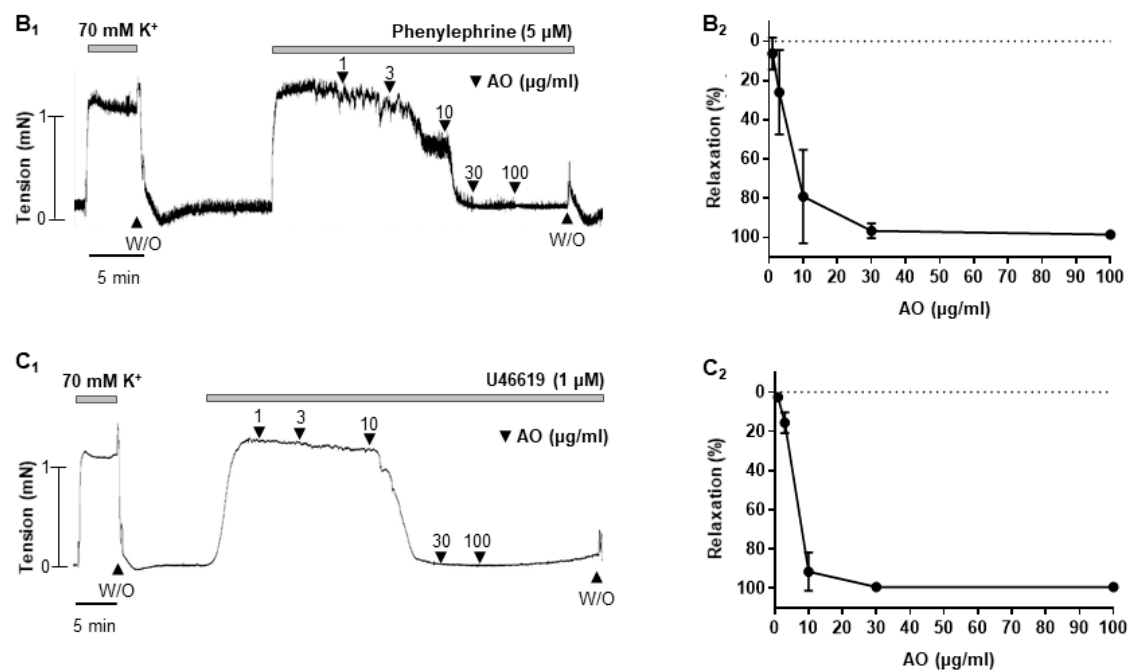
Figure 1. A. officinarum extract-induced vasodilation in rat mesenteric arteries. ( A 1 – C 1 ), data showing responses to cumulative administration of A. officinarum extract (1–100 µ g/mL) on high-K + ( A 1 ) or U46619 ( B 1 ) or phenylephrine ( C 1 ) -induced contraction. ( A 2 – C 2 ), statistical analysis of the relaxation response to A. officinarum extract. Mean ± SD (n = 7). Inset, representative trace showing responses to vehicle, DMSO (0.0005–0.05%). (W/O: wash out; AO: Alpinia officinarum